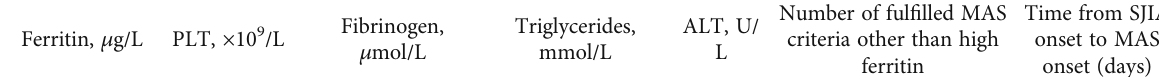
Table 4: Laboratory data of patients with sJIA at time of MAS diagnosis according to 2016 MAS criteria. Ferritin, μ g/L PLT, × 10 9 /L